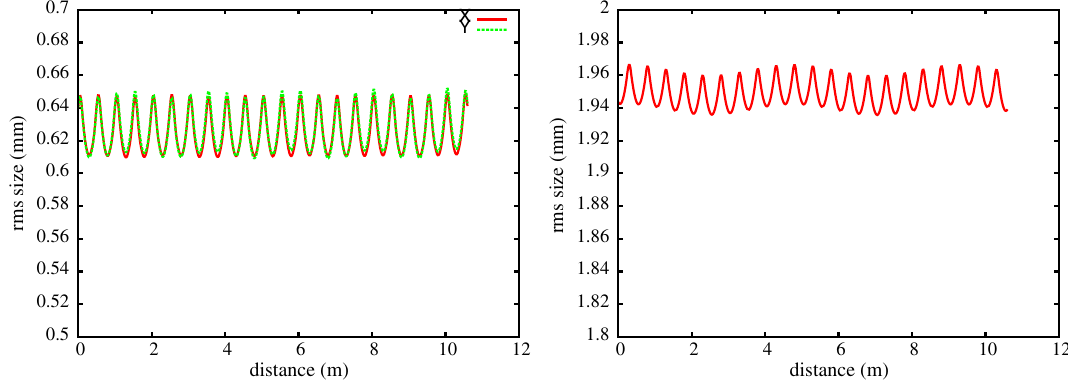
FIG. 8. Transverse (left) and longitudinal (right) RMS envelope evolution of the bunched beam inside a periodic focusing